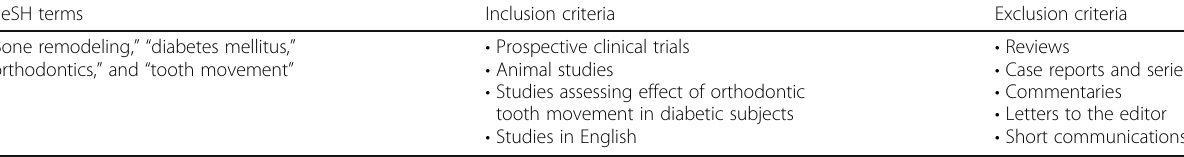
Table 1 A summary of MeSH terms, inclusion criteria, and exclusion criteria used for extracting literature from PubMed for this study MeSH